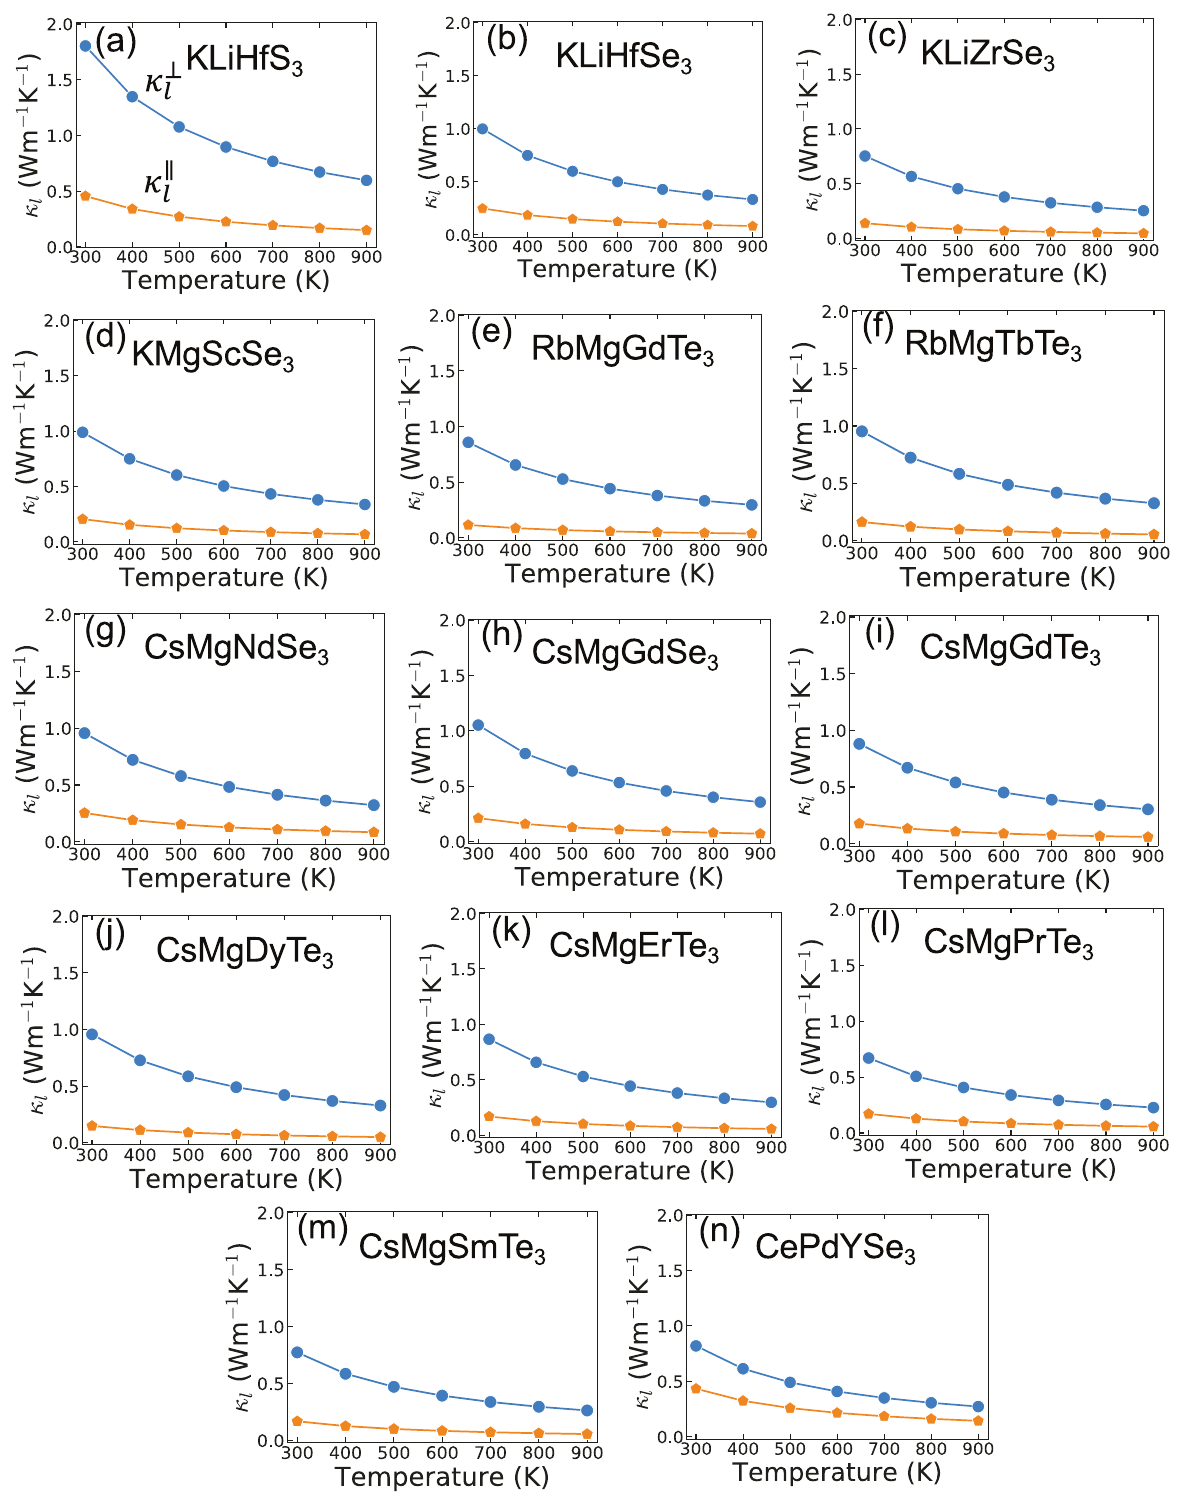
Fig. 5 Thermal-transport properties of the predicted stable compounds. Calculated temperature-dependent lattice thermal conductivity ( κ l ) of the 14 compounds that are selected randomly from the predicted stable and semiconducting quaternary chalcogenides- a KLiHfS 3 , b KLiHfSe 3 , c KLiZrSe 3 , d KMgScSe 3 , e RbMgGdTe 3 , f RbMgTbTe 3 , g CsMgNdSe 3 , h CsMgGdSe 3 , i CsMgGdTe 3 , j CsMgDyTe 3 , k CsMgErTe 3 , l CsMgPrTe 3 , m CsMgSmTe 3 , n CePdYSe 3 . κ k (orange pentagons) and κ ? (blue circles) indicate the components of κ l parallel and perpendicular l l to the stacking direction of the layers in the crystal structure of these compounds,